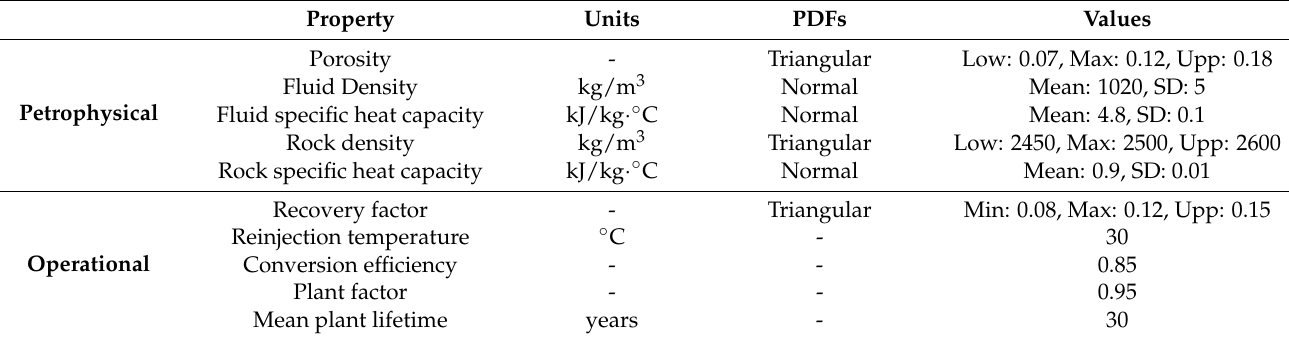
Table 1. Petrophysical and operational parameters used for the HIP and Hrec calculations in example 2 (Low and Upp correspond to the minimum and maximum temperature values assigned to the triangular distribution with lowest frequencies; Max—the value with the highest frequency; PDF—probability distribution function; SD—standard deviation). Property Units PDFs Values